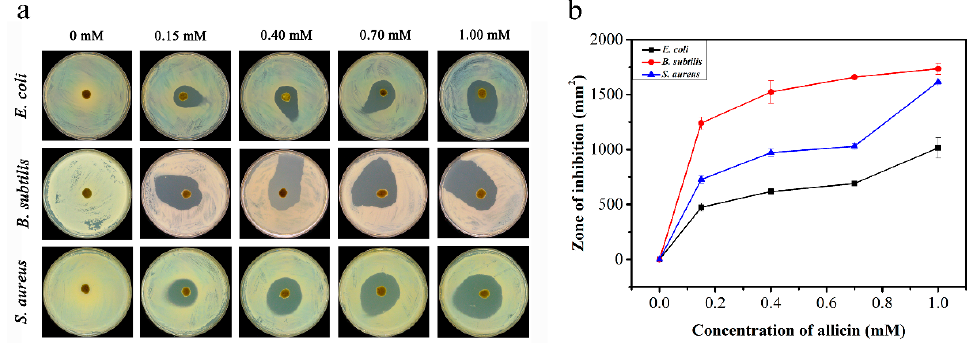
Figure 3. ( a ) Photographs of the inhibition zone after adding different concentrations (0 mM, 0.15 mM, 0.40 mM, 0.70 mM, 1.00 mM) of allicin to pomelo peel. ( b ) The area of the inhibition zone corresponds to Figure ( a